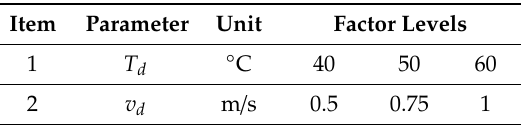
Figure 1. The best Artificial Neural Network (ANN) structure. Table 2. Process variables and their bounds.